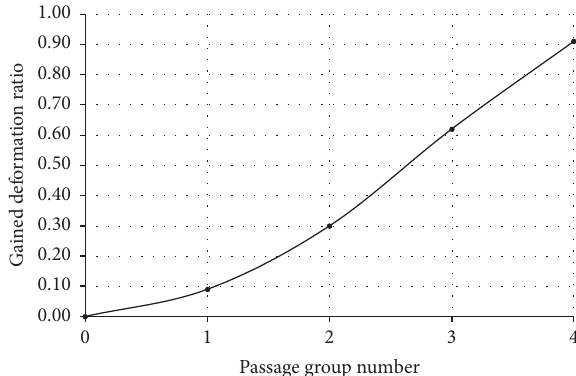
Figure 6: Te change of the accumulated logarithmic degree of the deformation at the frst stage of billet rolling after TE in passage groups: temperature range of rolling is 350 ° C–200 ° S ; there are 3 reductions in 1 passing after 1 heating; change in billet thickness during rolling is 24–9.7mm.